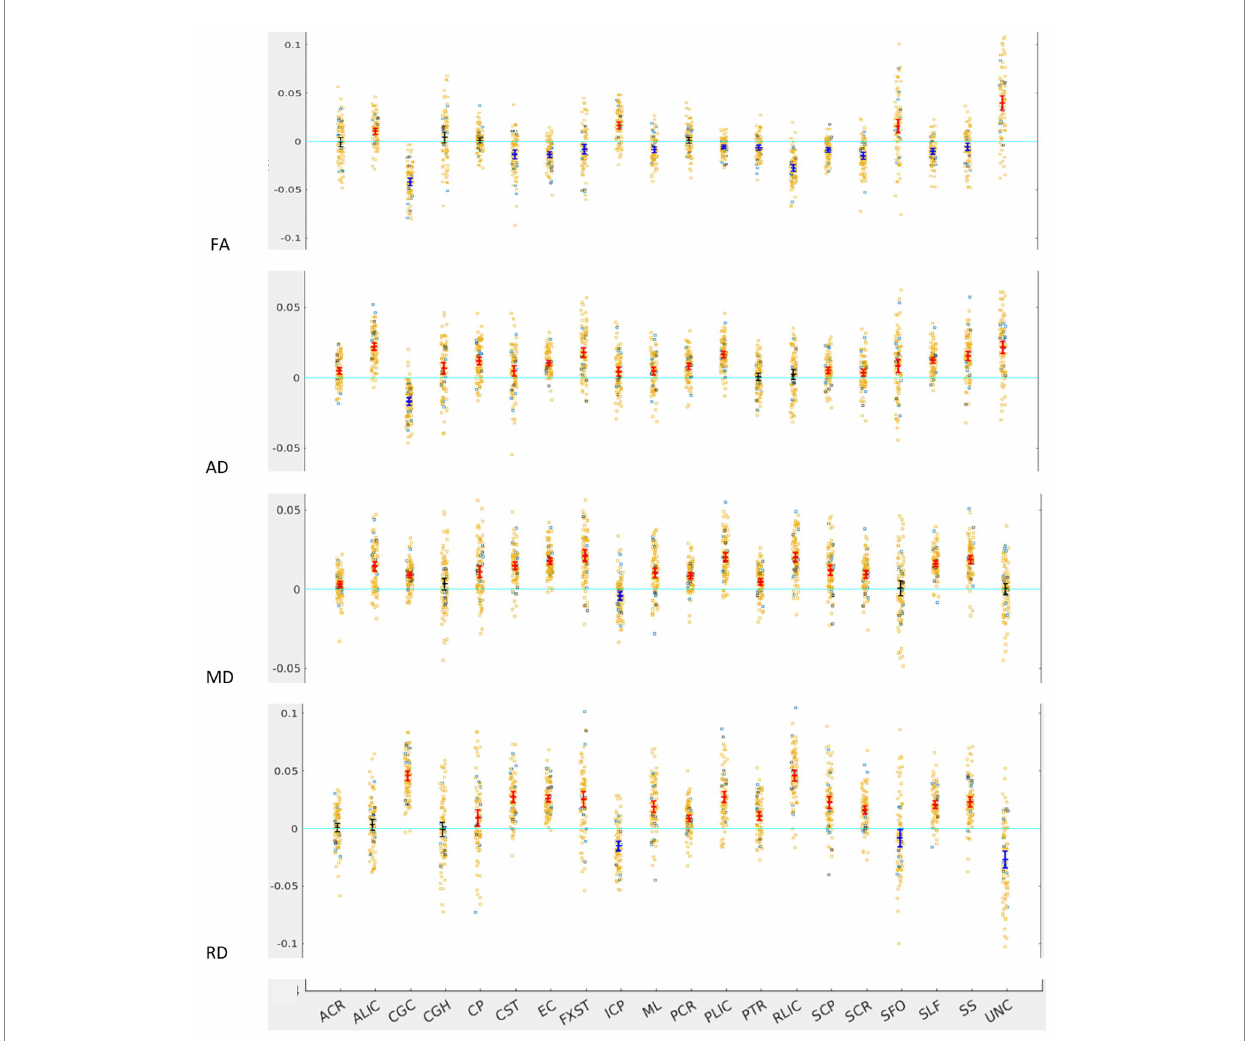
FIGURE 1 LI plotted for each of the 87 participants for the 20 bilateral tracts for DTI metrics, the mean and 95% CI are represented in the figure, 95% CI bars in red represents significant right lateralization (positive LI) of the tract while blue bar represents significant left lateralization (negative LI) of the tract. Yellow dots represent right-handed subjects (79) while blue dots represent left-handed subjects (9), subjects where handedness data was missing are plotted in black